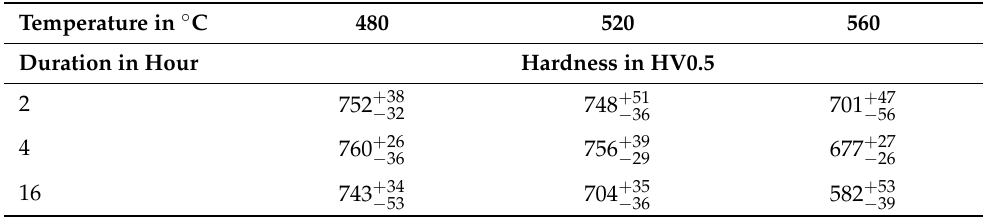
Figure 13. ( a – c ) are the nitriding hardness depth curves in HV0.5 depending on the temperature and duration of plasma nitriding. The scatter band shows the minimum and maximum hardness values interpolated to the respective equal distances. Note the drop near the surface may be due to edge effects. ( d ) shows the nitriding hardness depth (NHD) depending on the temperature and duration of plasma nitriding. ( a ) Hardness measurement of samples plasma nitrided at 480°C with different durations. ( b ) Hardness measurement of samples plasma nitrided at 520°C with different durations. ( c ) Hardness measurement of samples plasma nitrided at 560°C with different durations. ( d ) Nitriding hardness depth (NHD) depending on the temperature and duration of plasma nitriding. The linear regressions without onset are added to clarify the relationship of the layer thickness as a function of the root-time law. Table 6. Determined average core hardness in HV0.5 depending on the temperature and duration of plasma nitriding. The mean value, the minimum, and the maximum are given. The core hardness varies due to tempering effects during plasma